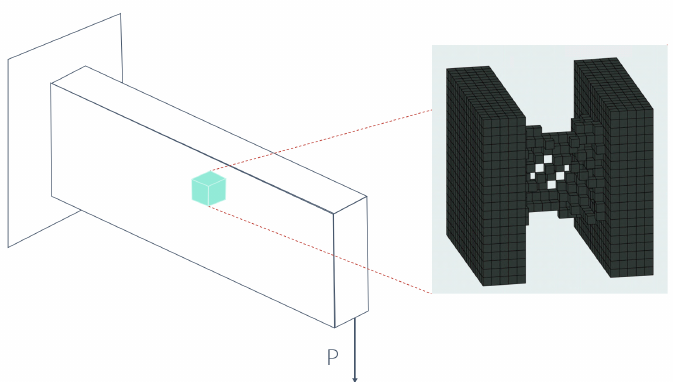
Figure 2. Optimized periodic unit cell for the bridge test example macro structure.